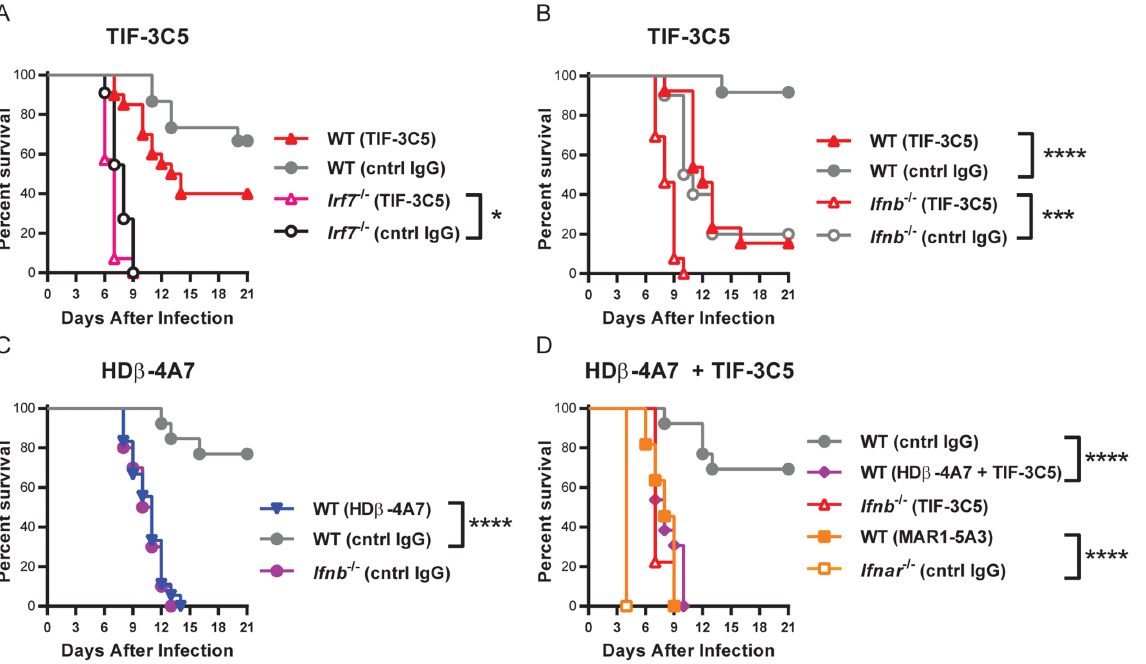
Fig 8. Type I IFN blocking mAbs enhance lethality of WNV infection. Wild-type or Irf7 -/- mice were administered 500 μ g of TIF-3C5 or isotype control mAb by intraperitoneal injection one day prior, and two days following subcutaneous infection with 10 2 PFU of WNV. B. Wild-type or Ifnb -/- mice received 250 μ g of TIF-3C5 or isotype control mAb one day prior, one day following, and three days following WNV infection. C. Wild-type or Ifnb -/- mice received 250 μ g of HD β - 4A7 or isotype control antibody one day prior and two days following WNV infection. D. Wild-type or Ifnb -/- mice received 250 μ g of HD β -4A7 antibody or isotype control one day prior and three days following WNV infection, as well as 500 μ g of TIF-3C5 antibody (or control) one day prior, one day following, and three days following infection. Wild-type and Ifnar1 -/- mice were given 500 μ g of MAR1-5A3 or isotype control mAb one day prior, one day following, and three days following infection. Survival was monitored for 21 days. Data represent 9 to 20 mice per group, from 2 or more independent experiments. * , P < 0.05; *** , P < 0.001; **** , P < 0.0001 (log-rank test).